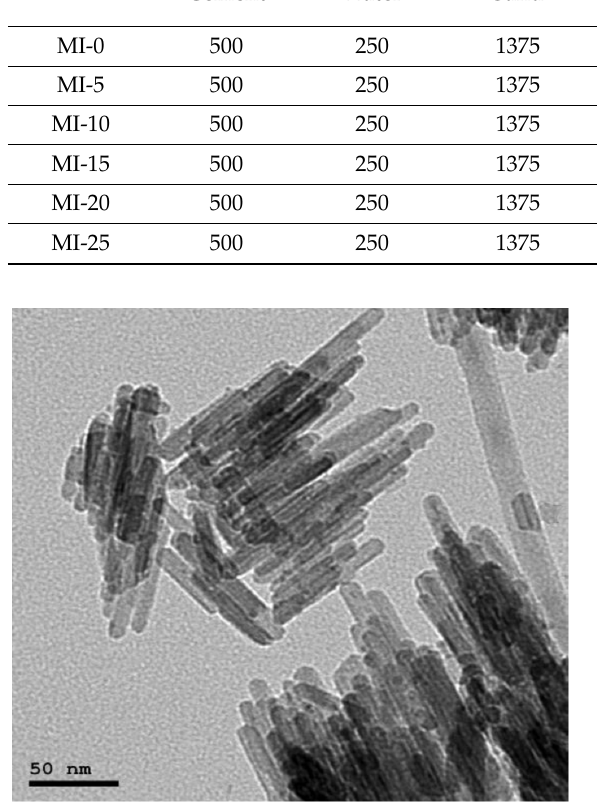
Figure 2. TEM micrograph for as ‐ prepared hematite NPs.